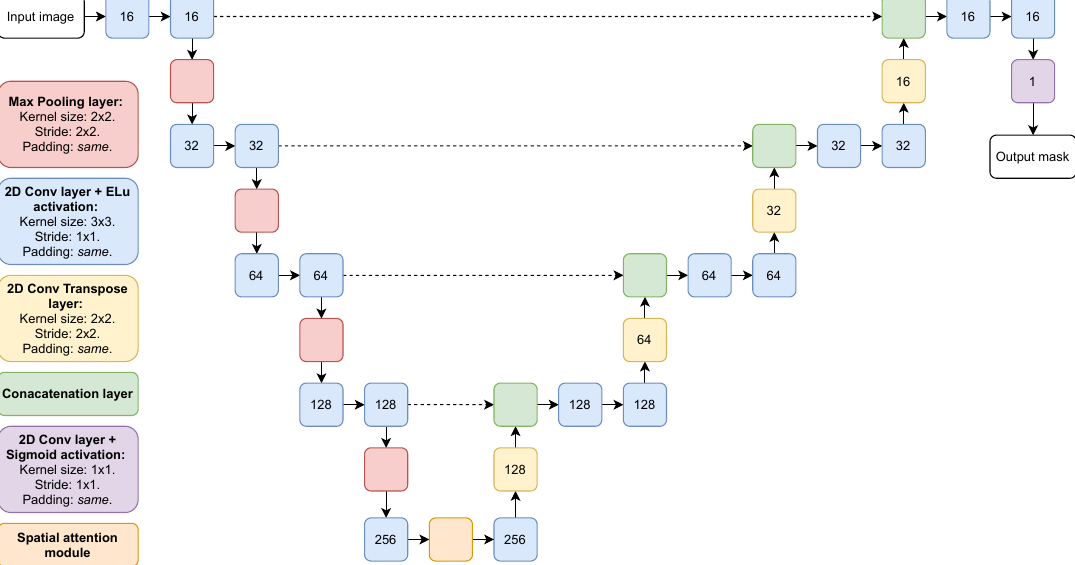
Figure 20. In-detail structure of the model proposed by Akhloufi et al. [38] with the inclusion of SA modules. The numbers inside the squares represent the number of filters in the corresponding